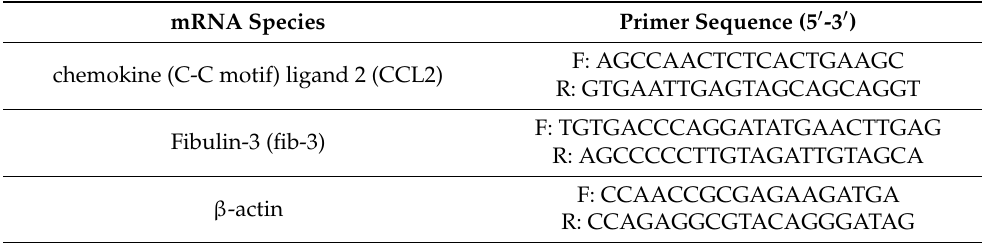
Table 1. The primer sequences for analyzing mRNA expression of CCL2 and fibulin-3. F: forward primer, mRNA: messenger RNA and R: reverse